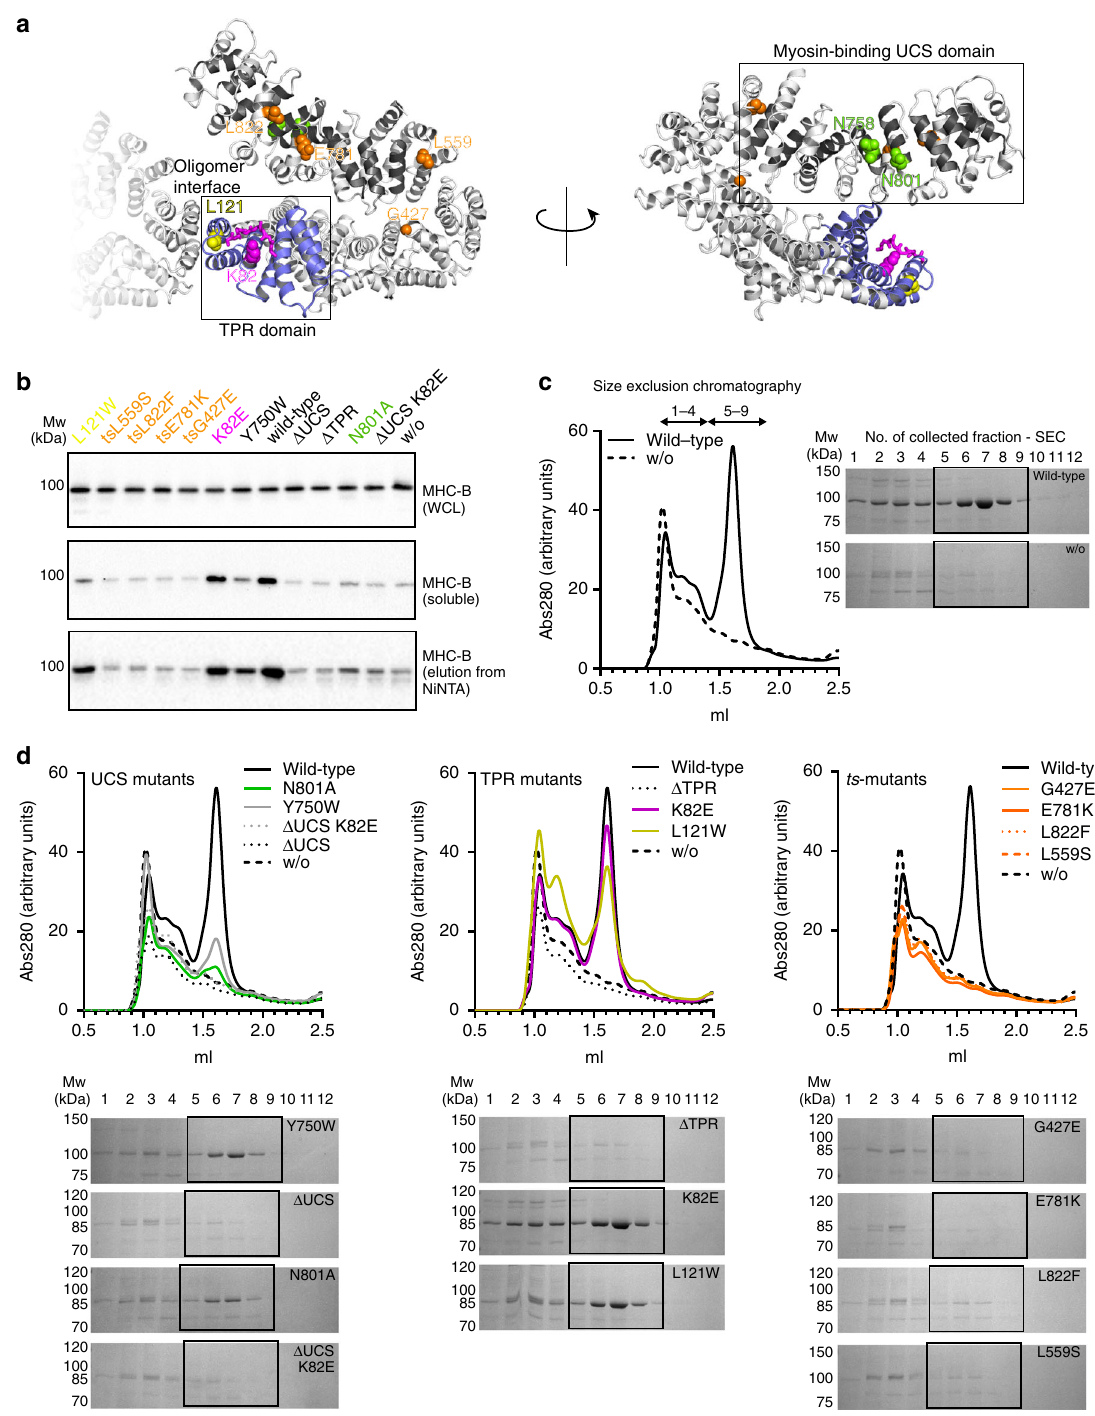
Fig. 2 Effect of UNC-45 mutant proteins on myosin production in insect cells. a UNC-45 mutations that were analyzed in the chaperone assay are shown on the crystal structure of the wild-type protein (PDB code: 4i2z). b Western blot analysis of co-expression of MHC-B with indicated UNC-45 mutant proteins in insect cells. Whole cell lysates (WCL), soluble fractions and elutions after small-scale NiNTA puri fi cation are shown for MHC-B. c SEC traces and corresponding SDS-PAGE gels for MHC-B puri fi ed from insect cells with and without co-expression of UNC-45. Fractions 1 – 4 cover the void/aggregate peak, while fractions 5 – 9 correspond to the elution volume of monomeric functional myosin. d Same analysis as in c for MHC-B co-expressed with UNC-45 UCS domain mutants, TPR domain mutants and ts domain as observed for other point mutations bordering the seen by the reduced levels of soluble MHC-B in the insect cell co- myosin-binding groove 24 . We therefore excluded the N758Y expression system (Fig. 2b and Supplementary Fig. 2a). The site- speci fi c N758Y mutant protein itself was not highly expressed in mutant from our analysis. Instead, we used the cellular chaperone insect cells, likely because the mutation destabilizes the UCS assay to look for a new site-speci fi c UCS mutation having an